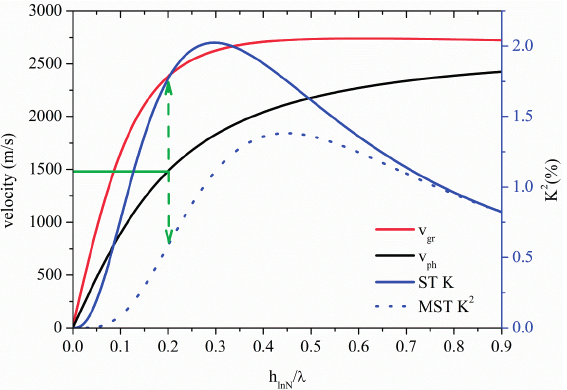
Figure 13. Phase and group velocity, and K 2 dispersion curves of the A 0 mode propagating along the MST and ST configurations on InN